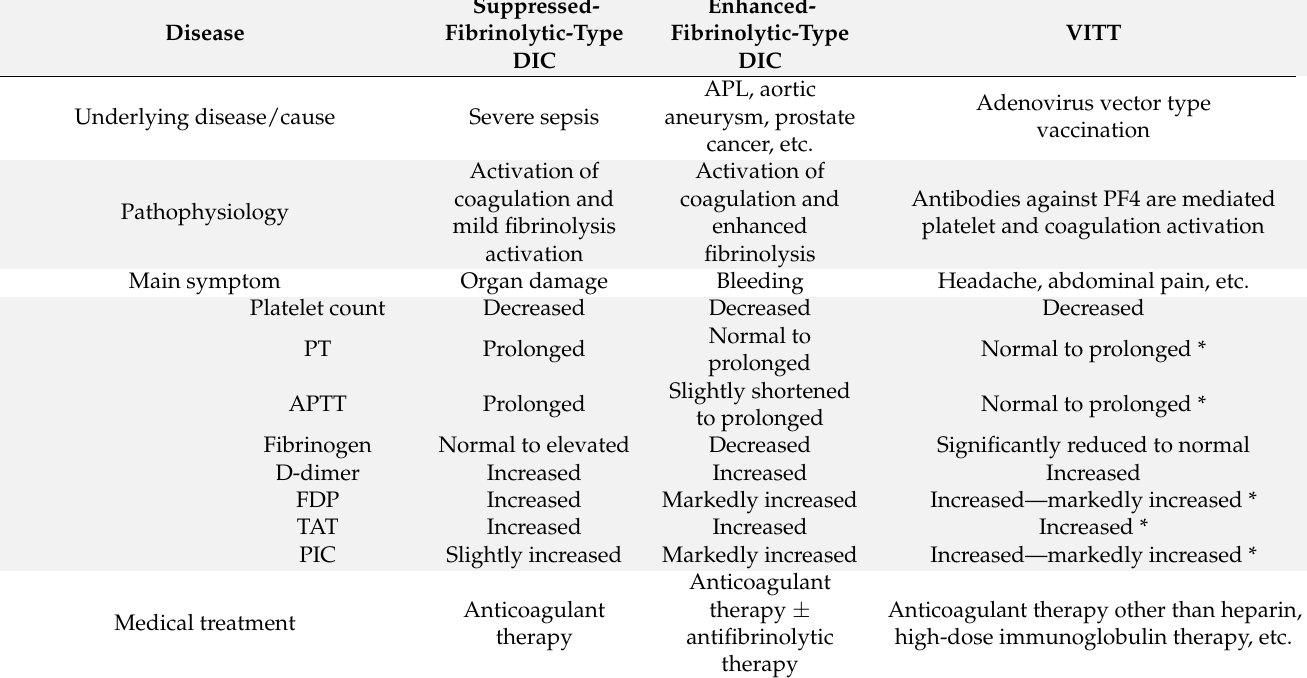
Table 5. Laboratory findings in typical cases of suppressed/enhanced-fibrinolytic-type DIC and